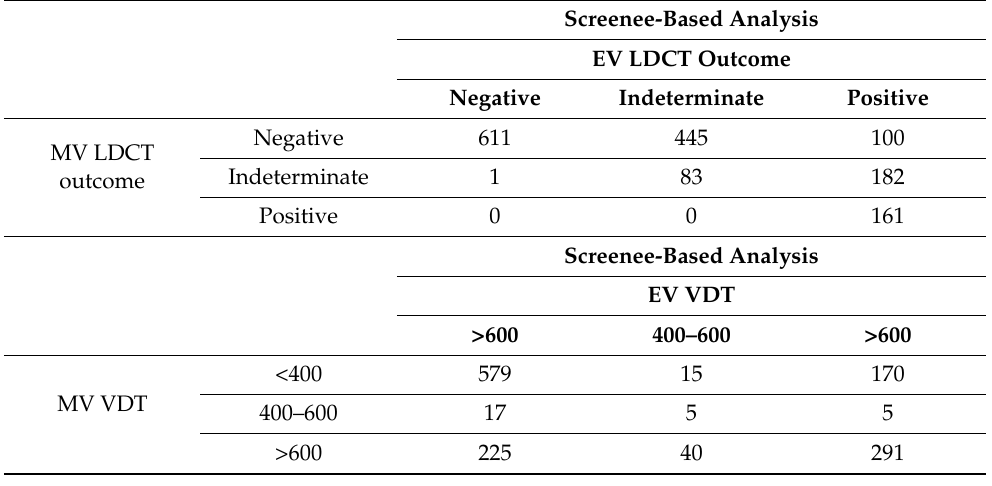
Table 2. Low-dose computed tomography (LDCT) outcomes and volume doubling time (VDT) cate- gories derived from measured volume (MV) and estimated volume (EV) for the screenee-based